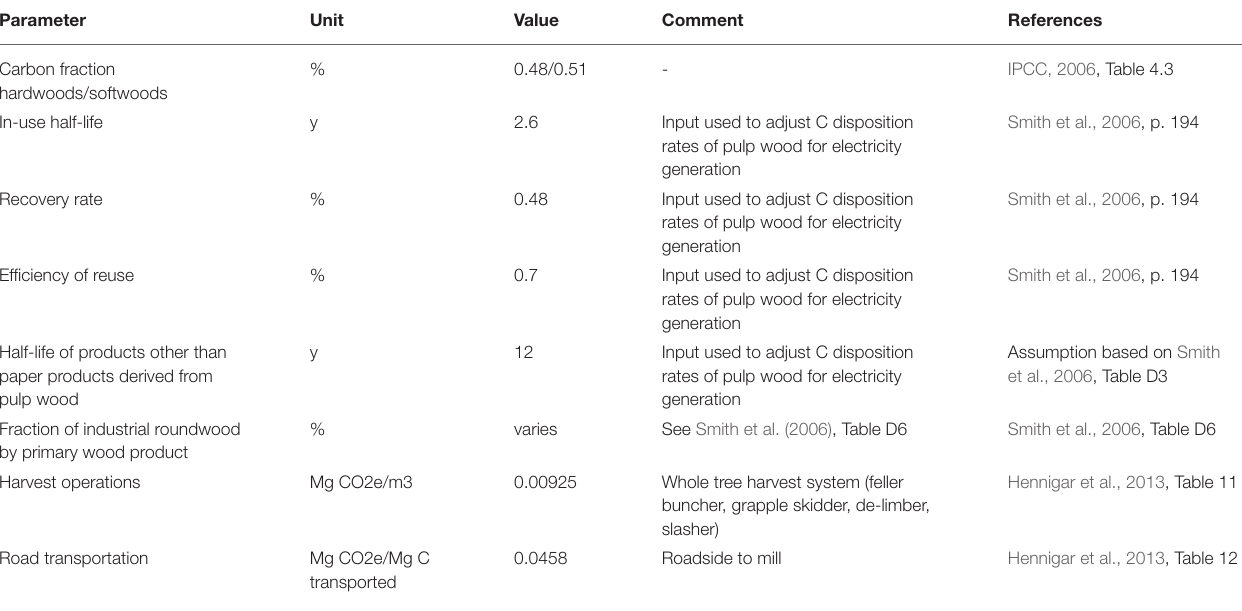
TABLE 5 | Input parameter for harvested wood products carbon life cycle assessment including bioenergy.